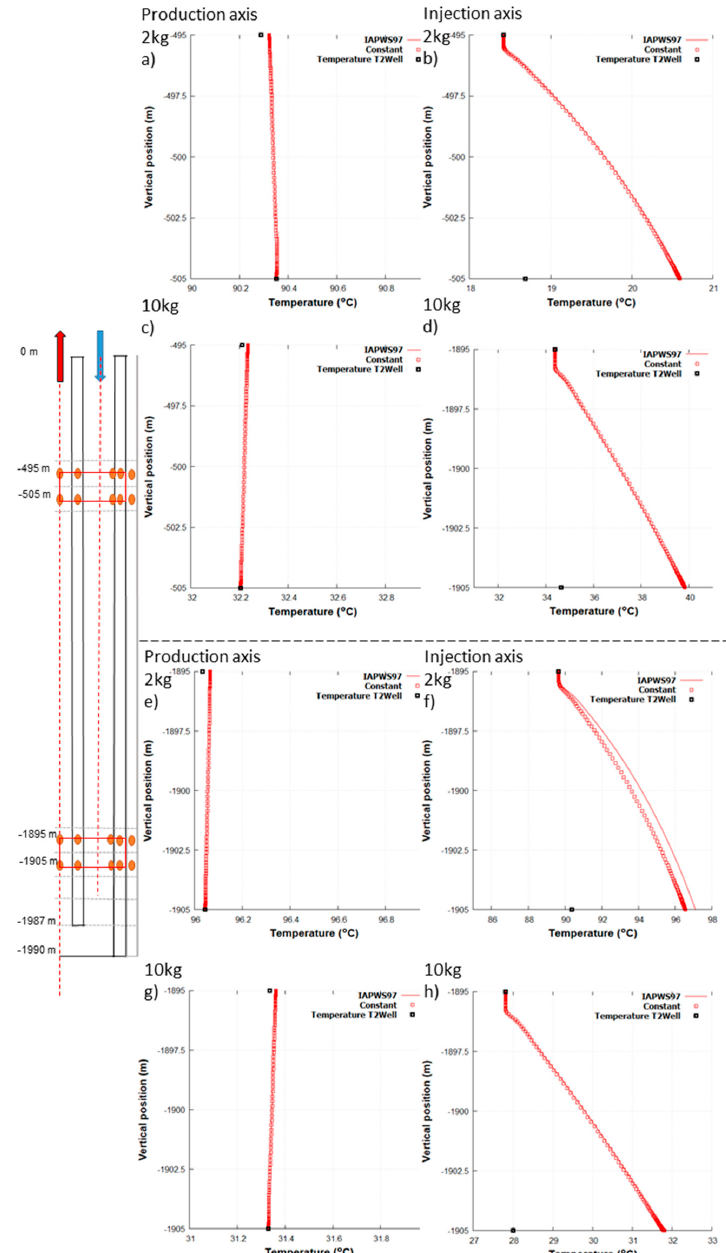
Figure 4. Temperature distribution in the production ( a , c , e , g ) and injection well ( b , d , f , h ) at the depth of 500 m ( a – d ), 1900 m ( e – h ) for the mass flow rate of 2 kg / s ( a , b , e , f ), 10 kg / s ( c , d , g , h ) compared to the T2Well temperature values taken after a simulating period of 1